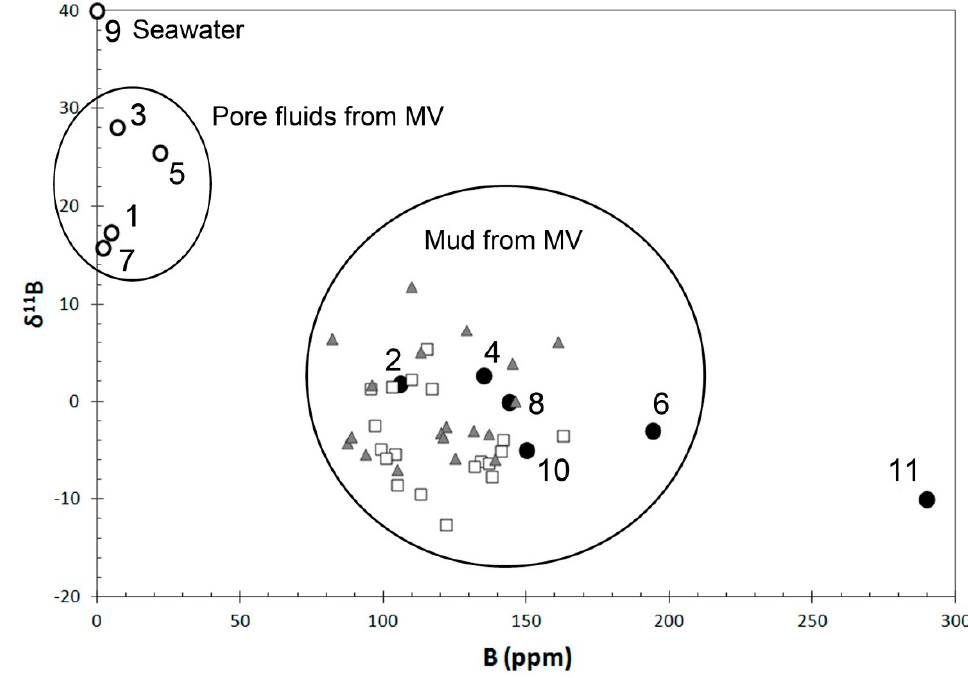
Figure 10. Summary of data of B-isotope trends and fluid/rock interactions in sedimentary basins: white squares, fixed B in xc; gray triangles, total B mw samples; 1, 2, Barbados pore fluids and mud respectively [117]; 3, 4, Makran pore fluids and mud [118]; 5, 6, Mediterranean pore fluids and mud [119]; 7, 8, Malaysia pore fluids and mud [120]; and 9, 10, 11, Seawater, source rock kerogen and muscovite pods from Gulf of Mexico, respectively [24].